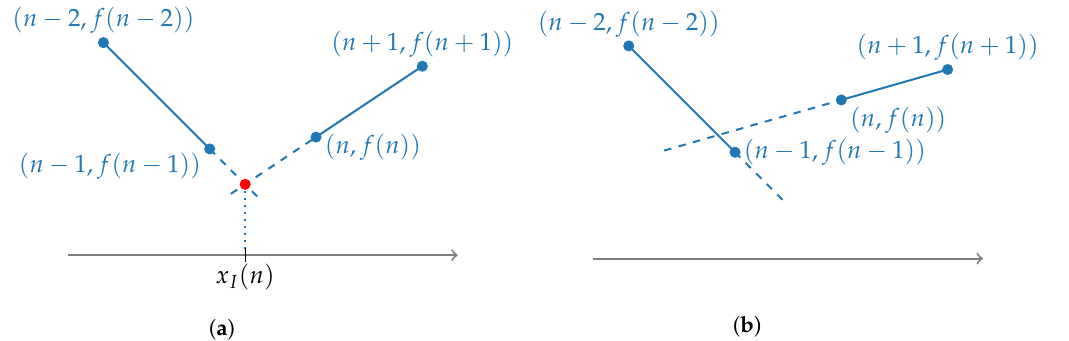
Figure 2. Example of existent and non-existent x I ( n ) . ( a ) The x -coordinate of the intersection belongs to [ n − 1, n ] . ( b ) The x -coordinate of the intersection does not belong to [ n − 1, n ]